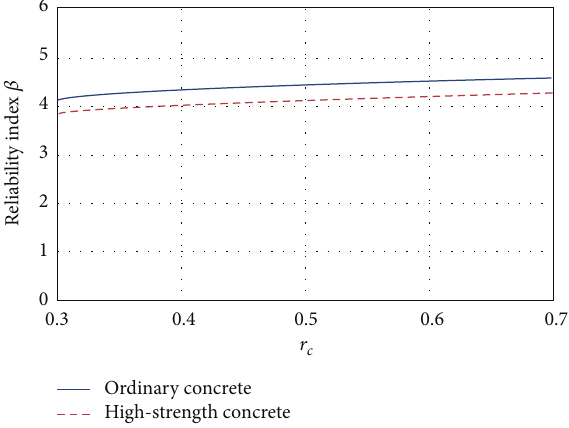
Figure 7: Reliability corresponding to torsion failure mode.